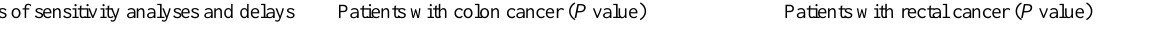
Patients with rectal cancer (N=243)Patients with colon cancer (N=405)Delay